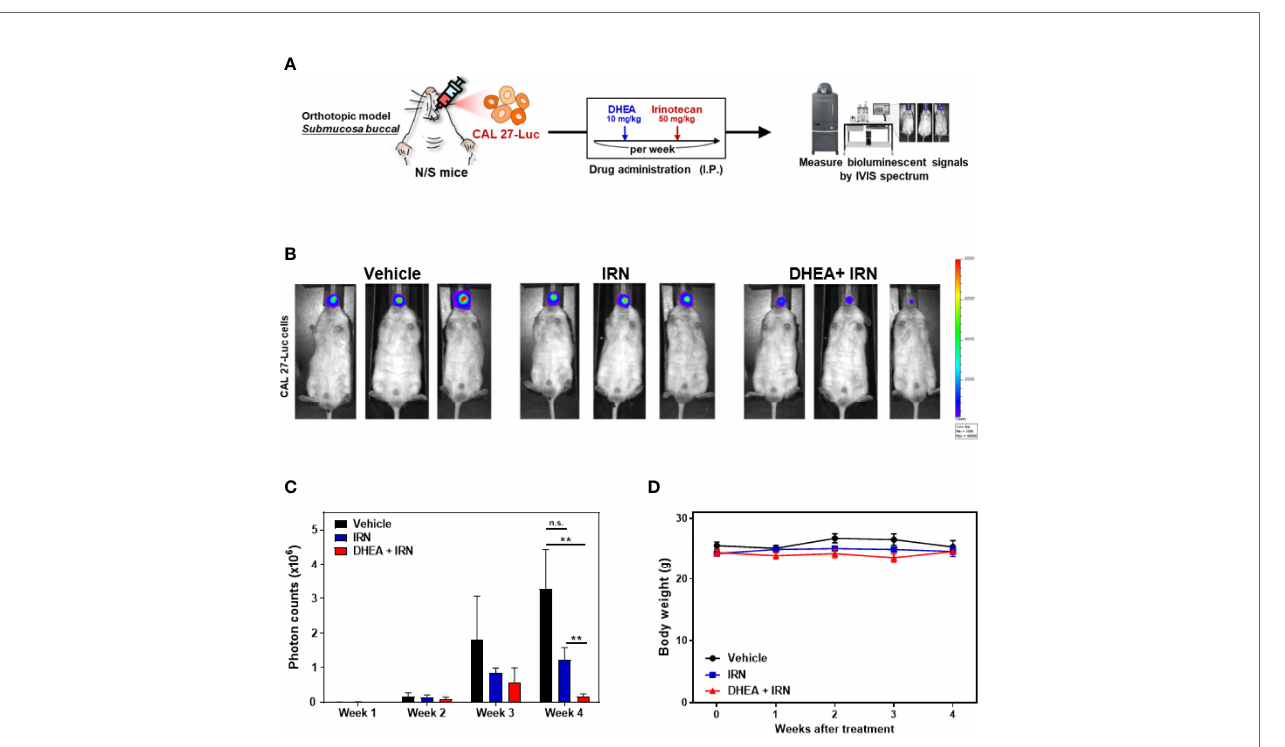
FIGURE 5 | DHEA combined with IRN further reduced tumor growth in HNSCC orthotopic mouse models. (A) Flow chart of the experimental schedule and drug administration. CAL 27 cells with luciferase expression (CAL 27-Luc) were injected into the buccal submucosa of mice. DHEA (10 mg/kg/once a week) and IRN (50 mg/kg/once a week) were injected intraperitoneally (IP). Tumor growth (measured by bioluminescent signals using the IVIS Spectrum Imaging System) and body weights were measured once a week. (B-D) Bioluminescence images (B) , quantitation of photon counts (C) , and body weights (D) of orthotopic mouse models following various treatments. Data represent mean ± SEM ( n = 5/per group). n.s. not signi fi cant; ** p < 0.01, compared to each other using